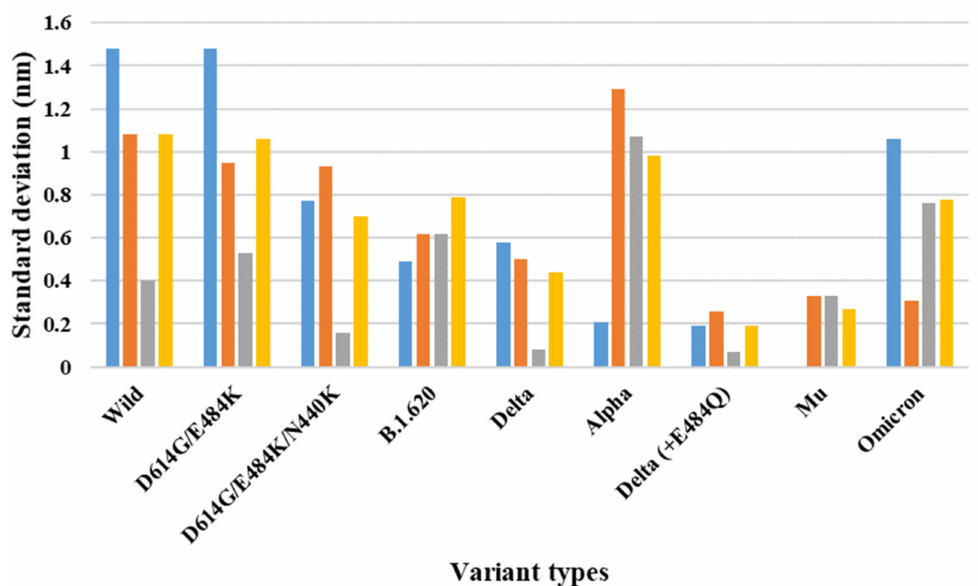
Figure 4. The standard deviation for the distance between V503 residues in each chain for the final MD trajectory in the three-open-complex form (7A98). The X axis denotes mutant types, and the Y axis denotes the standard deviation for distance (nm). Blue indicates the standard deviation between the AB and BC chains, orange indicates the SD between the AB and AC chains, gray indicates the SD between the AC and BC chains, and yellow indicates the SD among the A, B, and C